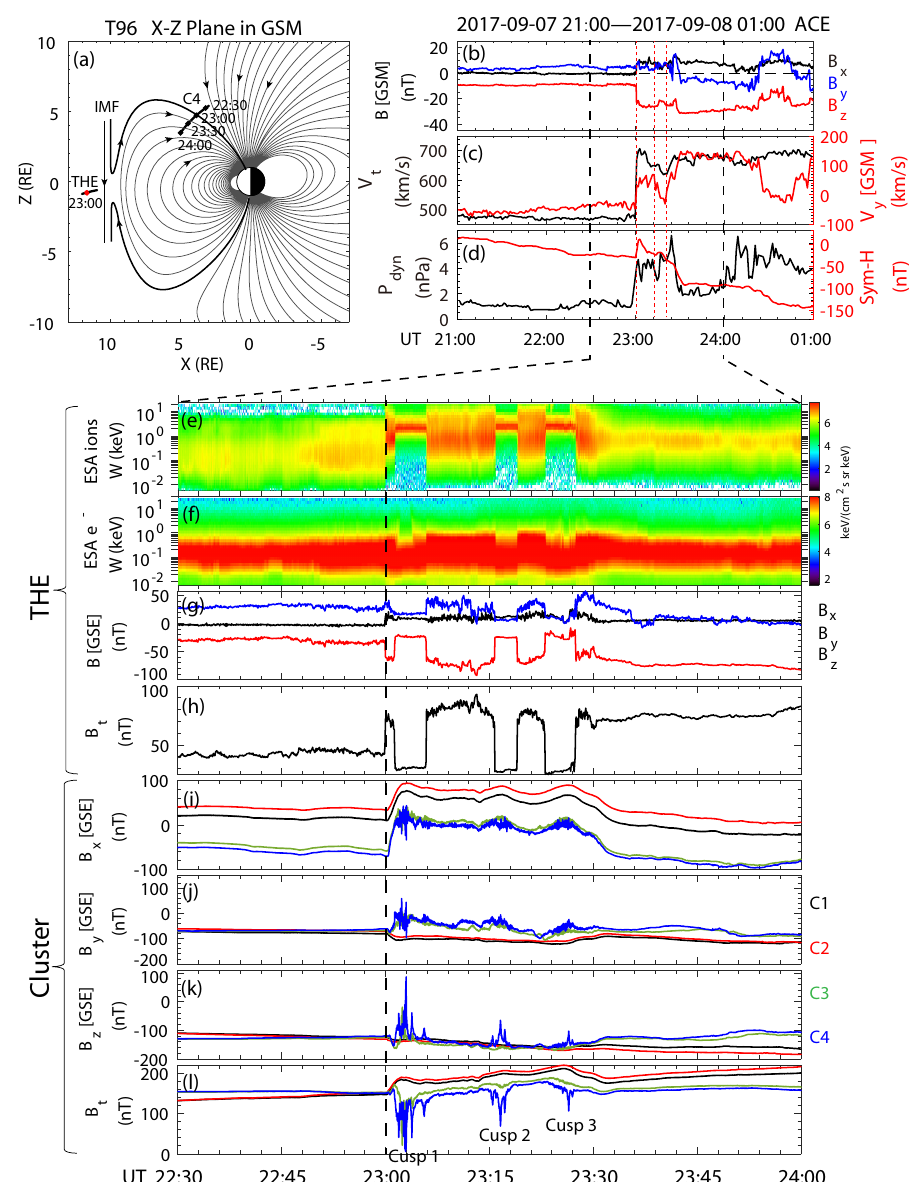
Figure 1. ( a ) Trajectories of Cluster C4 and THEMIS E in the GSM XZ plane from 22:30 to 24:00 UT on 7 September 2017. The magnetospheric field lines (gray lines) are obtained by the Tsyganenko T96 model, a cartoon of the IMF field lines is marked by the black lines and the field line directions are labeled by the black arrows; ( b – d ) The ACE observations at L1 from 21:00 UT on 7 September 2017 to 01:00 UT on 8 September 2017, including magnetic fields, solar wind velocity and dynamic pressure/Sym-H, respectively. The vertical red lines represent the times when THEMIS E went into the solar wind, as shown in panel ( e – h ). The THEMIS E observations from 22:30 to 24:00 UT on 7 September 2017, including energy spectra of ion and electron, magnetic fields in GSE coordinates and total magnetic field (B t ), respectively; ( i – l ) Magnetic field observations from four Cluster spacecraft. The arrival time (23:00 UT) of an IP shock is marked by the vertical dashed